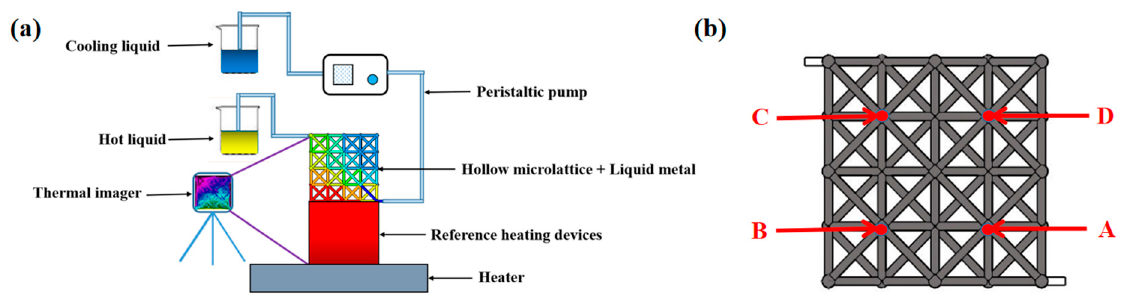
Figure 7. ( a ) Test setup and ( b ) test point of the heat dissipation performance. Table 3. Comparison of test and numerical results